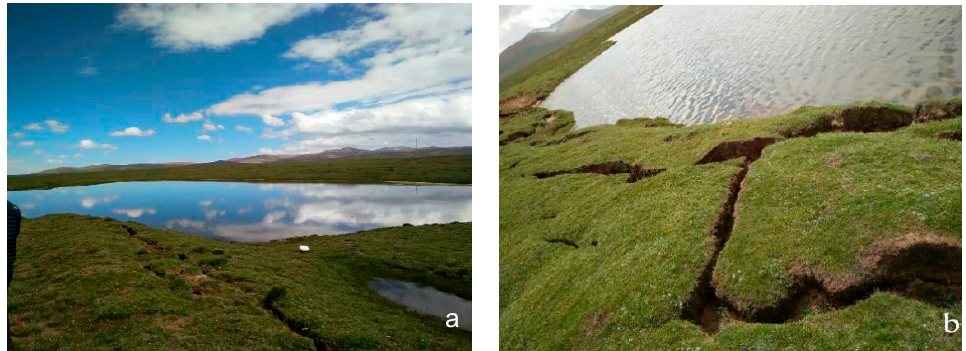
a Figure 1. A representative thermokarst lake and thermokarst collapse in the Beiluhe Basin (BLB) (photographs by Jie Dong); ( a ) thermokarst lake; ( b ) thermokarst collapse. Thermokarst lakes, which are ubiquitous in this landscape, are widely distributed in the ice-rich permafrost layer, for example in high mountains at a low latitude or pan-Arctic lowlands, such as in Siberia, Alaska, and Canada [4,5]. Thermokarst lakes were formed by the melting of massive amounts of ground ice or the thawing of ice-rich permafrost, followed by local ground subsidence and water collection in the created depressions [6]. Thermokarst lakes and their variations have a